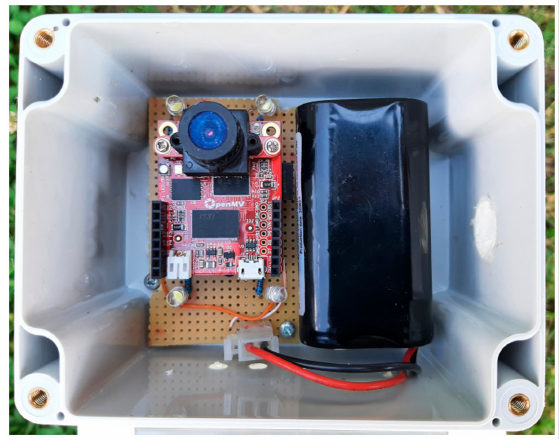
Figure 2. Arrangement of the electronic components inside the waterproof box (without cover). The GPS and GSM modules are on the backside of the circuit.